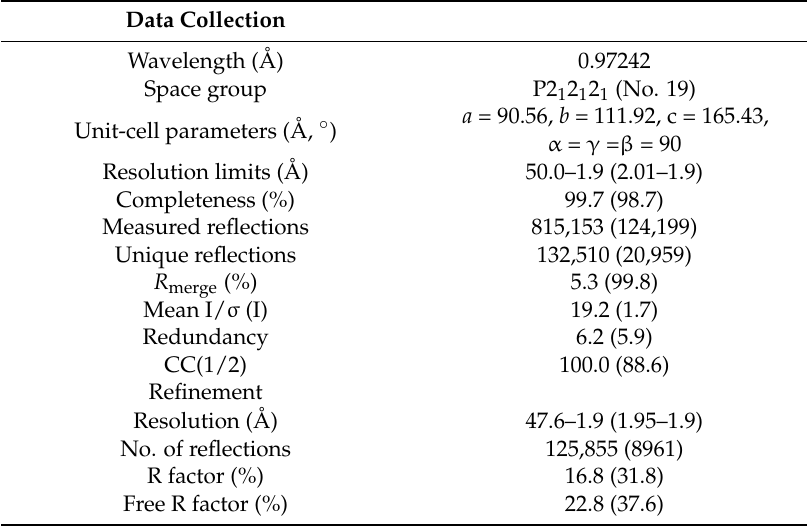
Table 1. Data collection and refinement